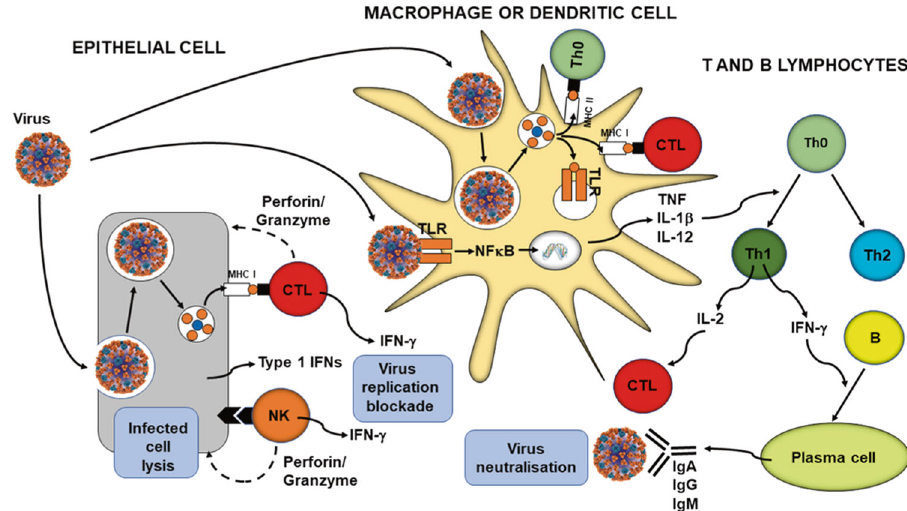
Fig. 2 Overview of anti-viral immunity. B B-cell, CTL cytotoxic T-cell, IFN interferon, Ig immunoglobulin, IL interleukin, MHC major histocompatibility class, NF κ B nuclear factor kappa-light-chain-enhancer of activated B cells, NK natural killer cell, Th helper T-cell, TLR toll-like receptor, TNF tumour necrosis factor. Taken from ref. [1].